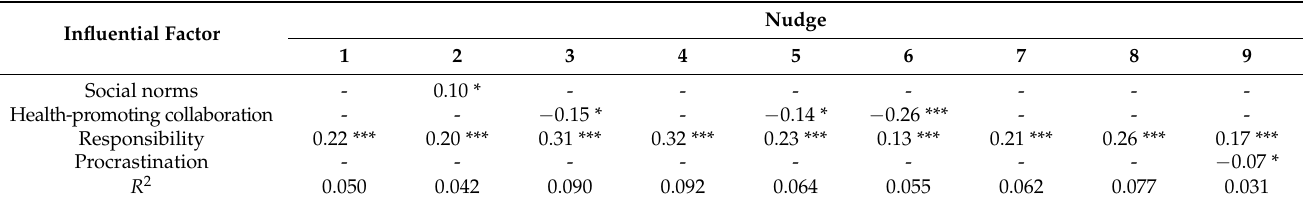
Table 4. Multiple regression analyses results of influential factors on the acceptance of each nudge.